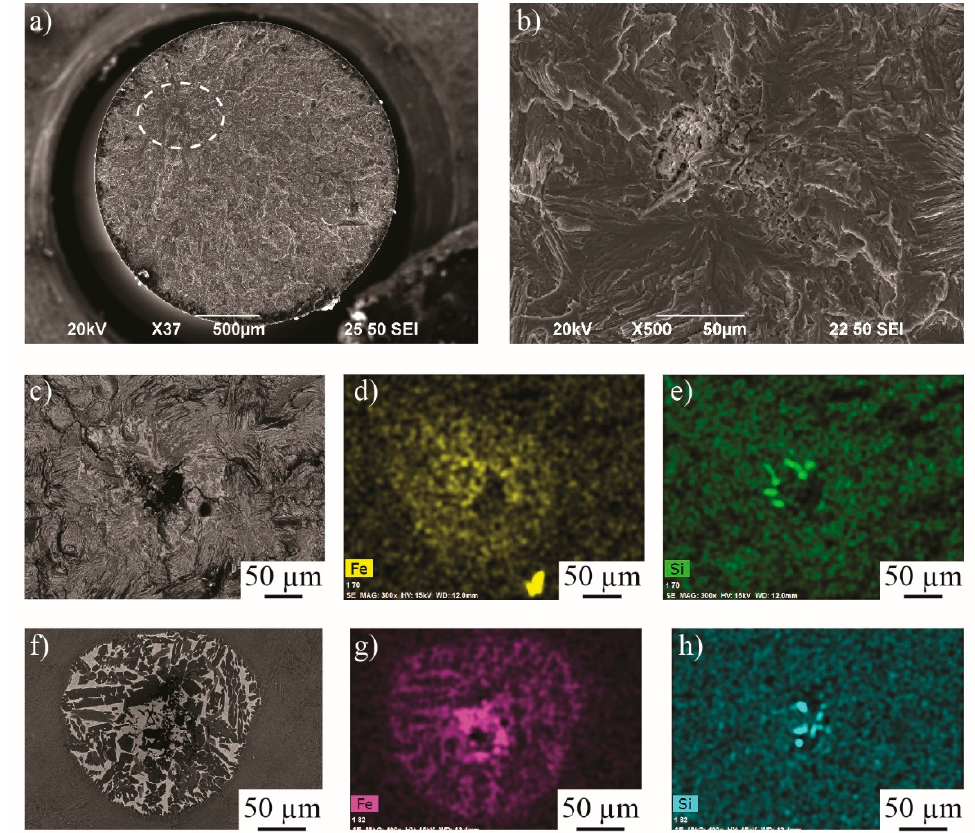
Figure 6. SEM analysis of a TNM + tensile sample densified at 1325 ◦ C after rupture at room temperature ( a – e ) and comparison to a sample free of deformation ( f – h ). ( a ) Overview of the sample section with the crack initiation site circled; ( b ) enlargement of the site; ( c ) back-scattered electron image of the very centre of the initiation site; ( d ) corresponding EDX mapping of Fe; ( e ) corresponding EDX mapping of Si; ( f ) contaminated particle in a non-deformed sample taken from an as-SPSed billet of the TNM + alloy consolidated at 1325 °C; ( g ) corresponding EDX mapping of Fe; and ( h ) corresponding EDX mapping of Si.